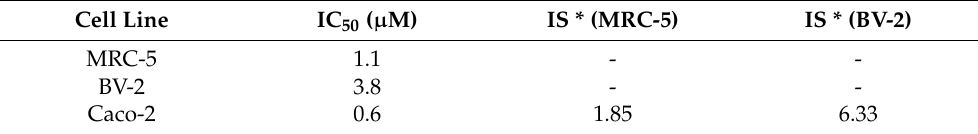
Table 2. IC 50 and selectivity index of MRC-5, BV-2, Caco-2 and RD for BmPLA2. Cell Line IC 50 ( µ M) IS * (MRC-5) IS * (BV-2) MRC-5